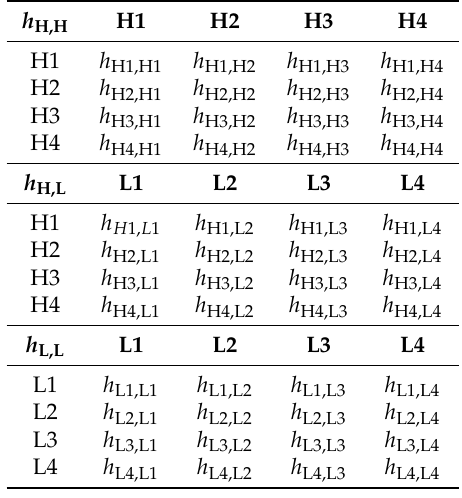
Table A1. Matrix elements of Hamiltonian: h β , α = h α , β